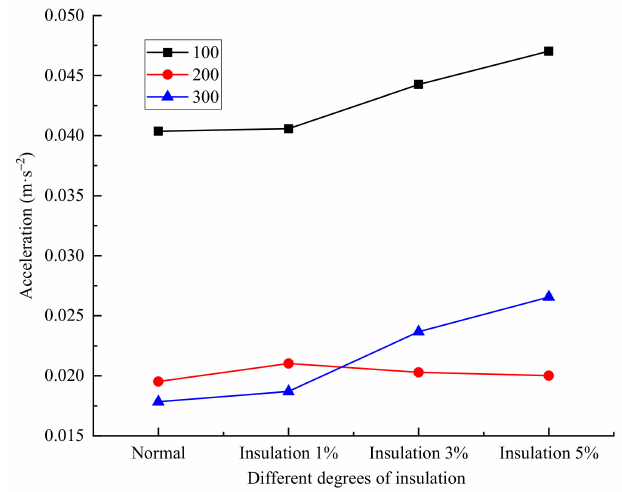
Figure 12. Acceleration amplitude change of different inter-turn short circuits at the first 300 Hz.